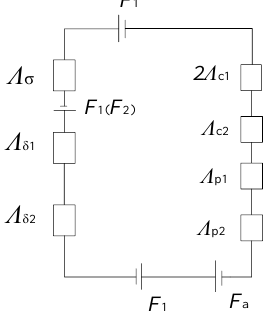
Figure 2. Equivalent magnetic circuit diagram.